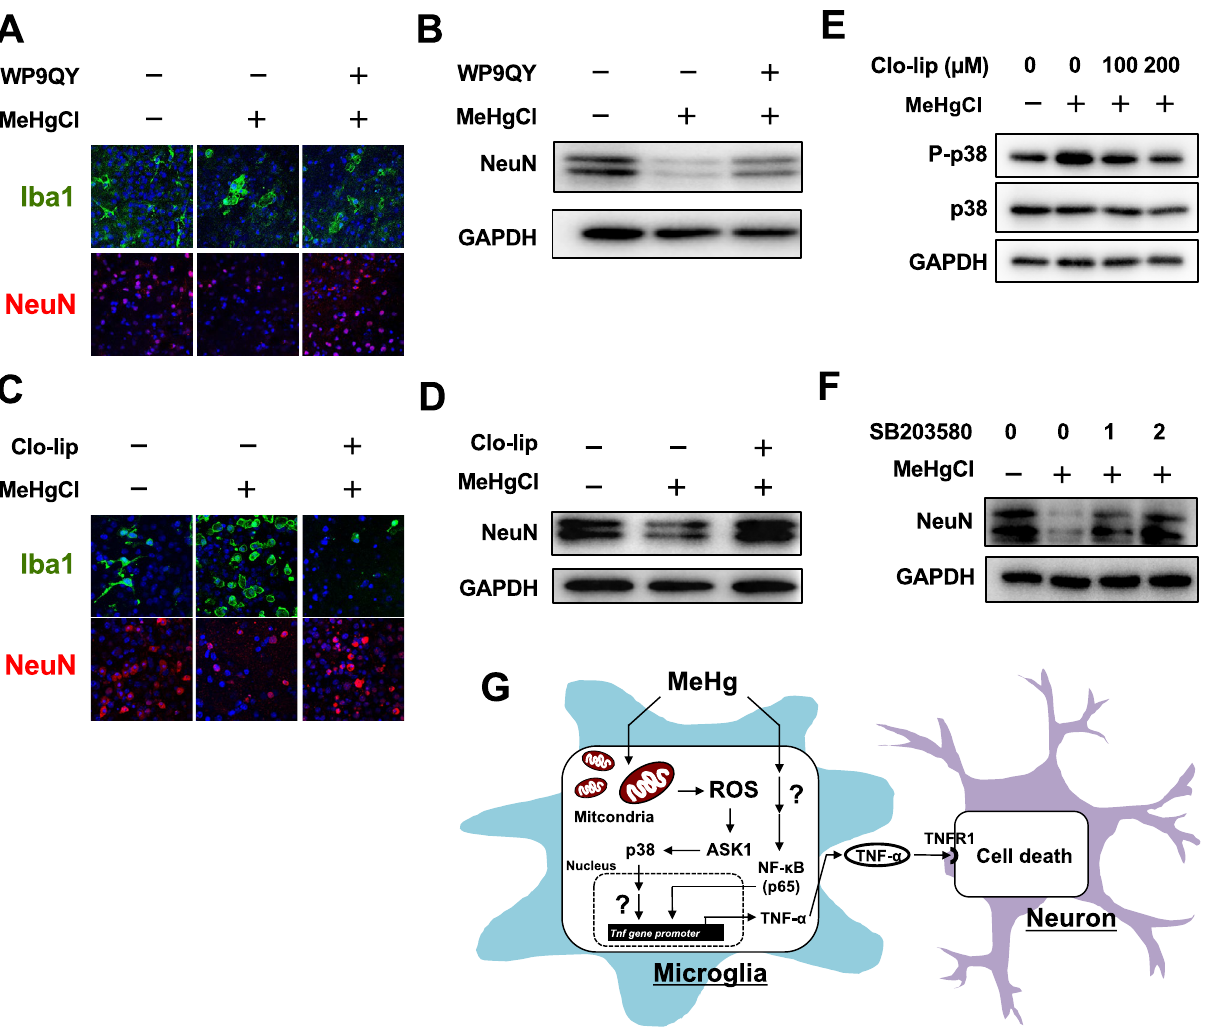
of MeHgCl for 24 h and immunostained for Iba1 (green) or NeuN (red). ( b ) Western blotting of NeuN was performed in the same conditions as in A. ( C ) Mouse brain slices were treated with 100 µM of liposomal clodronate (Clo-lip) for 72 h. The slices were exposed to 50 µM of MeHgCl for 24 h and immunostained for Iba1 (green) or NeuN (red). ( D ) Western blotting of NeuN was performed in the same conditions as in C. ( E ) Six hours after exposure to MeHgCl, Western blotting of P-p38 and p38 were performed. ( F ) Indicated concentrations of SB203580 (SB; p38 inhibitor) were pretreated for 30 min and the slices were exposed to 50 µM of MeHgCl for 24 h, followed by Western blotting of NeuN. ( G ) The mechanism underlying methylmercury- induced neuronal cell death through the induction of TNF-α